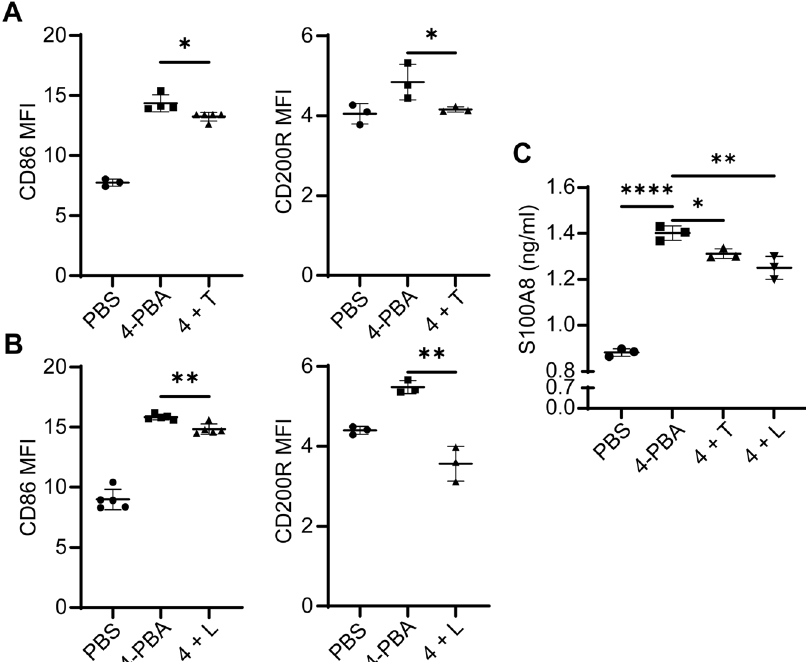
Fig. 5 Inhibition of PPAR γ or STAT3 reduces the generation of resolving neutrophils by 4-PBA. A Flow analyses of CD200R and CD86 levels on WT neutrophils treated with PBS, 4-PBA (1 mM; 24 hours) or pre-treated with T0070907 (0.5 µM) for 2 hours followed by 4-PBA (1 mM) stimulation for 24 hours ( n = 3). B Flow analyses of CD200R and CD86 expression levels on WT neutrophils treated with PBS, 4-PBA (1 mM; 24 hours) or pre-treated with LLL12 (0.5 µM) for 2 hours followed by 4-PBA (1 mM) stimulation for 24 hours ( n = 3). C ELISA analyses of S100A8 levels from WT neutrophils treated with PBS, 4-PBA (1 mM; 24 hours) or pre-treated with T0070907 (0.5 µM) or LLL12 (0.5 µM) for 2 hours followed by 4-PBA (1 mM) stimulation for 24 hours ( n = 3). Data were plotted as mean ± SD. ** P < 0.01, * P < 0.05 using two-sided Student ’ s t test ( A and B ). **** P < 0.0001, *** P < 0.001, ** P < 0.01, * P < 0.05 using one-way ANOVA test followed by the post-hoc Sidak multiple comparisons test ( C ). 4, 4-PBA; T, T0070907; L,